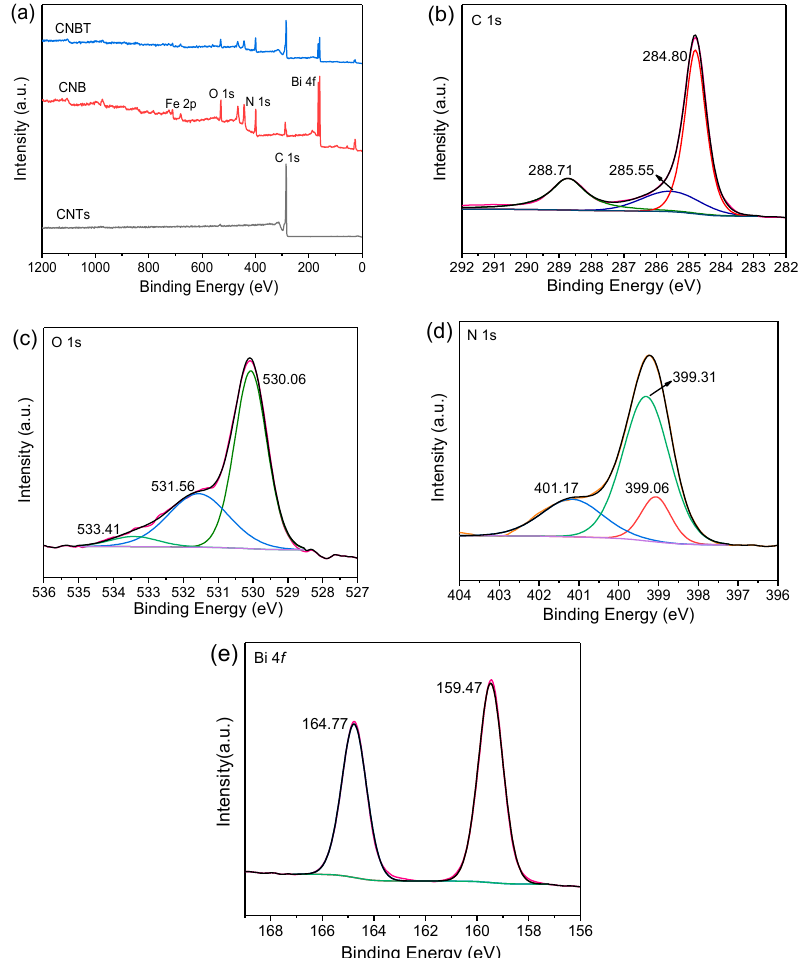
Figure 6. ( a ) Full XPS spectra of CNTs, CNB, and CNBT. Characteristic spectra of CNBT, ( b ) C 1s, ( c ) O 1s, ( d ) N 1s, ( e ) Bi 4f.